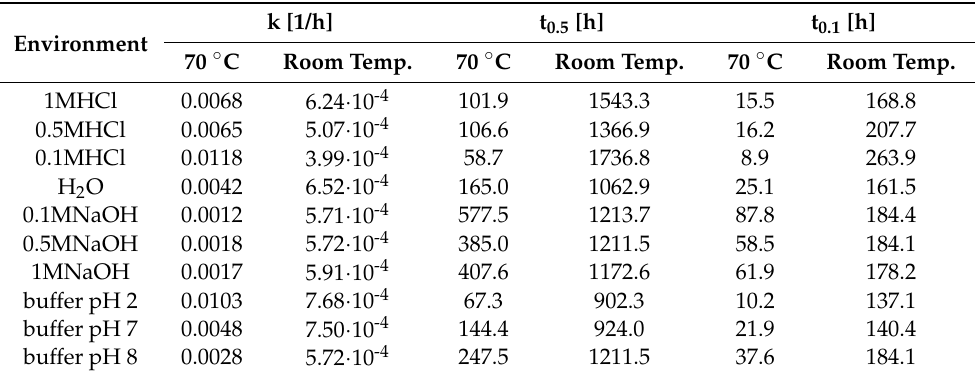
Table 4. Values of calculated kinetic parameters of the grapiprant degradation.